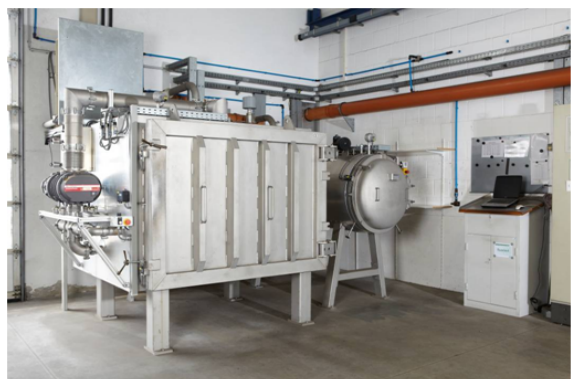
Figure 7. (Oxy-)fluorination chamber used for the treatment of the technical fibers, with permission from Fluor Technik System GmbH.